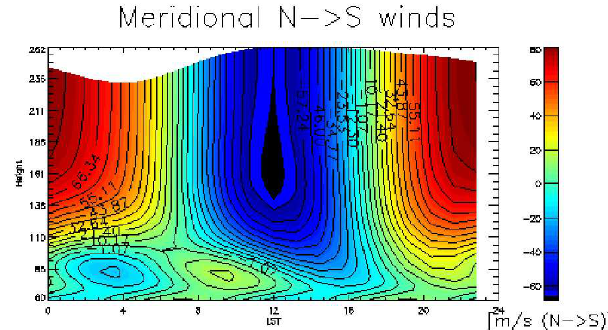
Fig. 8. The meridional wind speeds(positive southward), local solar time (LST) vs. height, from MarTIM with the (2,2) tide, for solar minimum conditions, L s =0 ◦